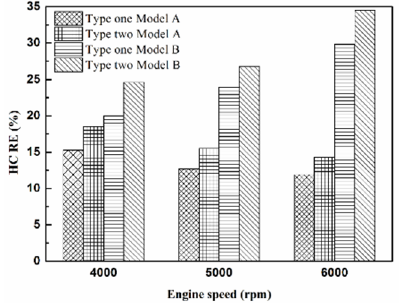
Figure 11. The HC RE at control voltage 5 V. Table 6. The maximum and minimum values of HC removal e ffi ciency at control voltage 5 V. Parameter